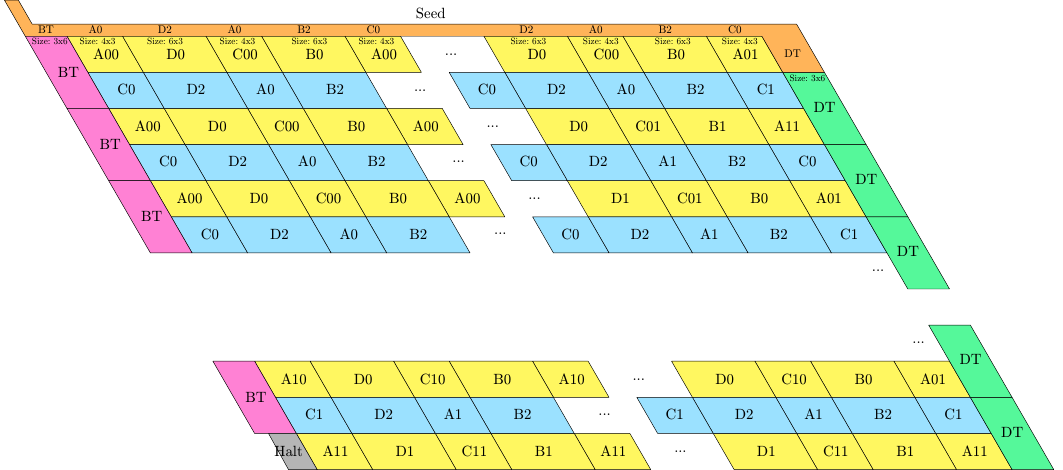
Figure 16. Triangular grid partition into regions populated with the proper bricks. Color coding: Seed-row in orange; Zig-rows ( Ð ) in yellow; Zag-rows ( Ñ ) in blue; Left Turns ( ã Ñ ) in pink; and Right Turns ( Ð â ) in